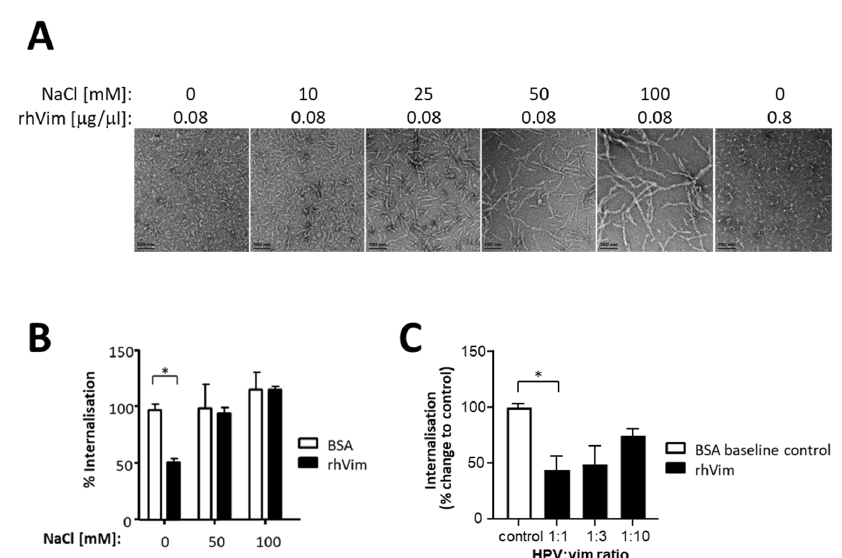
Figure 1. The formation of filamentous rhVim at NaCl concentrations of 50 mM and higher abolishes its modulatory effect on HPV16-PsVs internalisation by NIKS cells. ( A ) Structural analysis of rhVim was performed by negative staining transmission electron microscopy. rhVim was pre-incubated with varying NaCl concentrations at room temperature for 1 h prior to staining and imaging. ( B ) Quantification of viral internalisation was performed by flow cytometry of NIKS cells infected with AF488-conjugated HPV16-PsVs pre-incubated with rhVim or BSA control at a 1:1 ( w / w ) ratio at room temperature in the presence of varying concentrations of NaCl. ( C ) AF488-conjugated HPV16-PsVs were pre-incubated with increasing rhVim concentrations or BSA control at room temperature in the absence of NaCl before assessment of viral internalisation by flow cytometry. Experiments were quantified by a quadrant analysis of the dot plots and presented as % change relative to the mean fluorescence intensity of cell infected with HPV/BSA control which was set as 100%. Combinatorial analyses of the three independent experiments are presented. Significance was calculated by means of one-way ANOVA and Tukey post hoc tests. Only statistically significant differences are indicated. * p < 0.05.